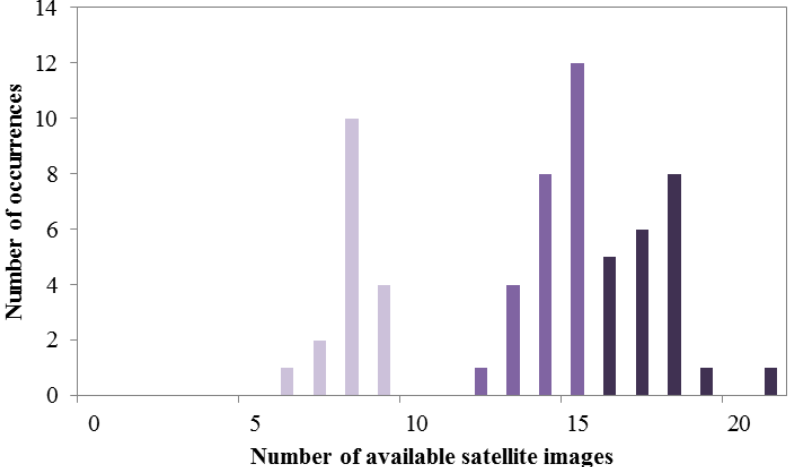
Figure 6. Aggregation of the fields according to the number of